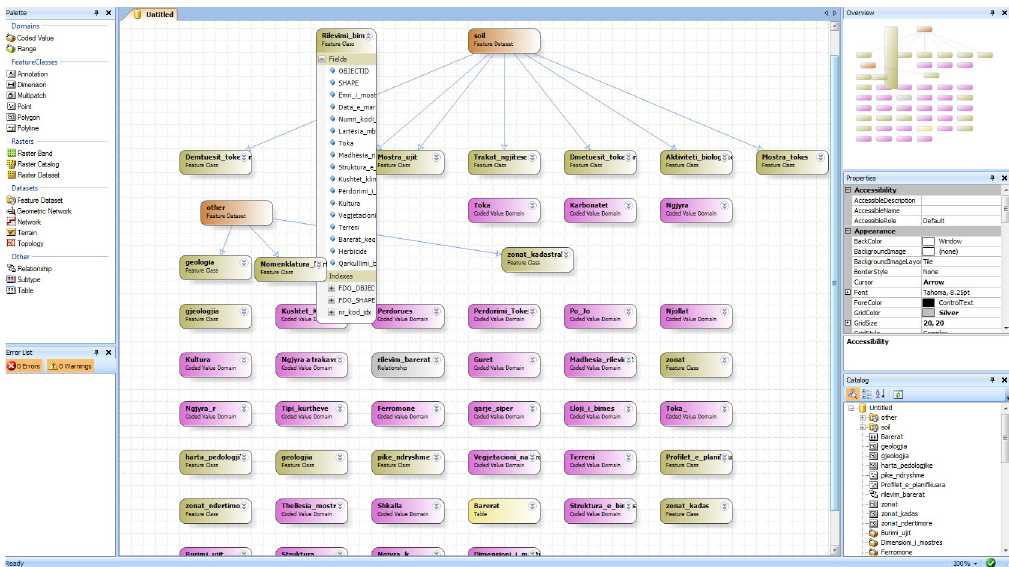
Figure 5. Geodatabase design